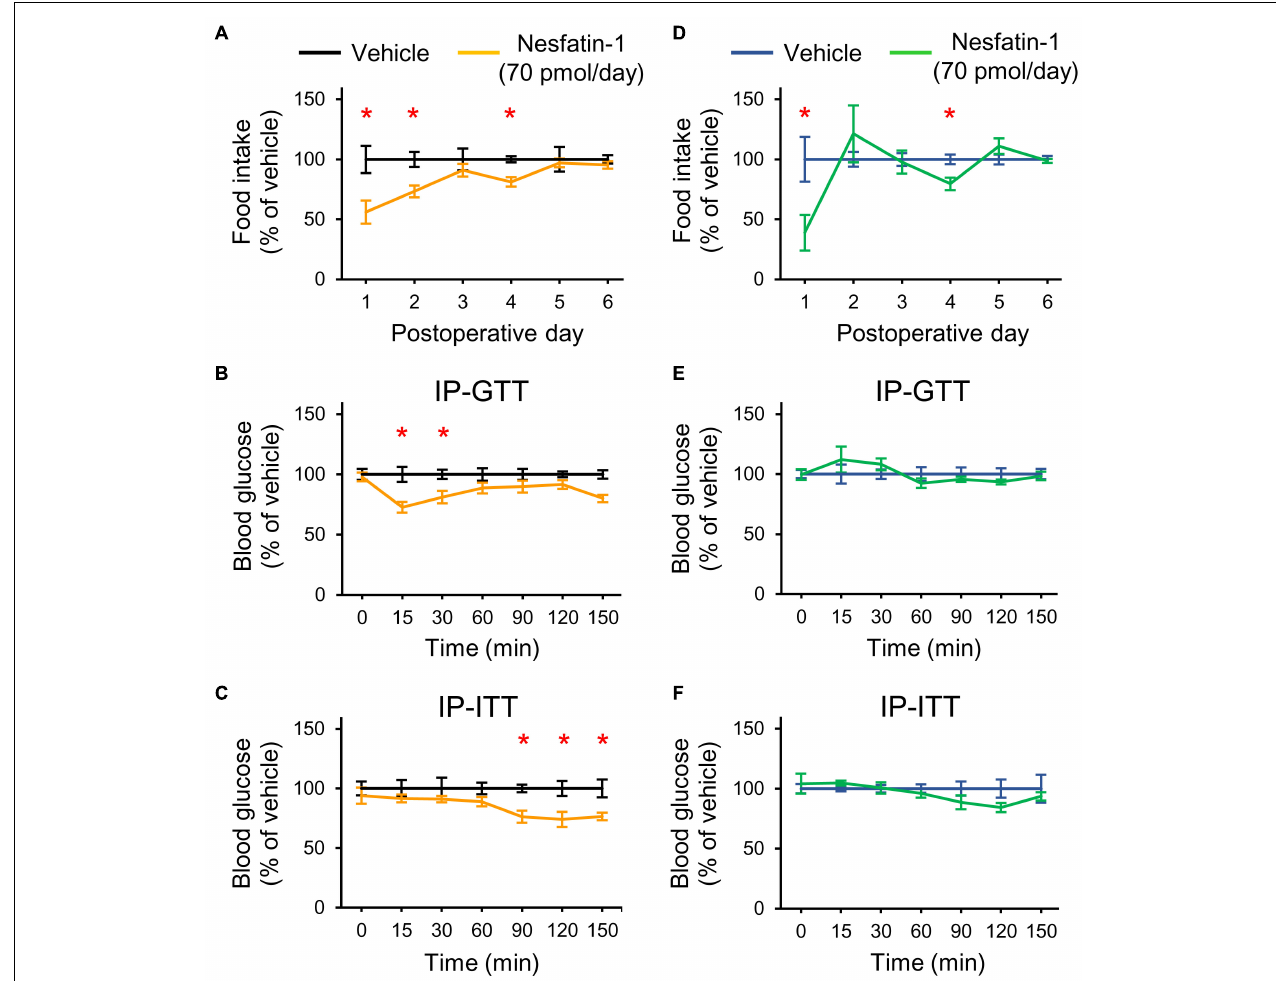
FIGURE 6 | Effects of chronic icv nesfatin-1 (70 pmol/day) or vehicle infusions on the food intake and glucose homeostasis of NN and PR rats. Day zero was the day of cannula and infusion pump implantations as well as the beginning of the treatments. The tests were performed at the end of the treatment period (7 days). (A) Relative food intake of NN rats. Student’s t -test, vehicle vs. nesfatin-1, day 1: * p = 0.013, day 2: * p = 0.007, day 4: * p = 0.003. (B) IP-GTT shows increased glucose tolerance of NN-nesfatin-1 rats. Two-way RM ANOVA, effect of phenotype: F ( 1 , 60 ) = 17.554, p = 0.002, effect of time: F ( 6 , 60 ) = 81.649, p < 0.001, effect of phenotype × time: F ( 6 , 60 ) = 3.760, p = 0.003. (C) IP-ITT shows increased insulin sensitivity. Two-way RM ANOVA, effect of phenotype: F ( 1 , 60 ) = 19.324, p = 0.001, effect of time: F ( 6 , 60 ) = 23.382, p < 0.001. Tukey multiple comparison tests, vehicle vs. nesfatin-1 within day * p < 0.05 for (B,C) . (D) Relative food intake of PR rats. Student’s t -test, vehicle vs. nesfatin-1, day1: * p = 0.029, day4: * p = 0.011 (E,F) IP-GTT and IP-ITT data of PR rats, respectively. No significant differences were seen. Means ± SEM, n = 6 for all